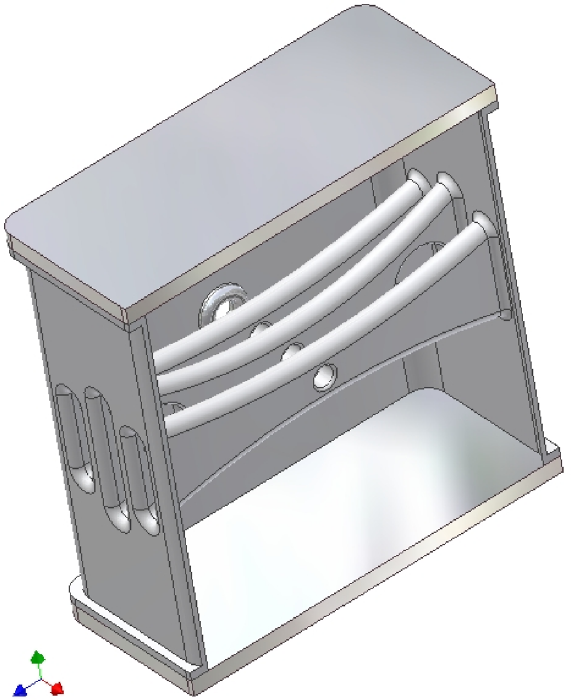
FIG. 4. (Color) Cutaway of the proposed ladder resonator and two cross sections. Different tapering of the central stem with respect to the other two and 11 mm-long beam ports give full voltage flatness over the four gaps. Two coupling holes, close to the basis of the central stems, ensure a 4 MHz splitting between the operational (cid:18) mode and the next higher